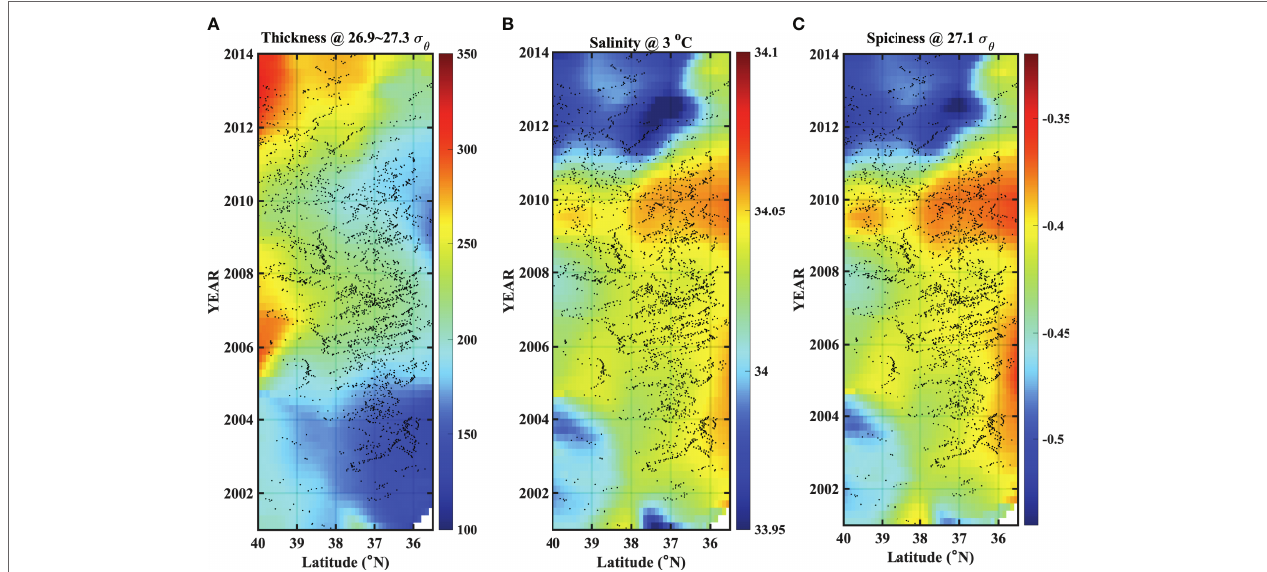
FIGURE 4 | (A) Hovmoller diagram for the ESIW thickness (meter) from Argo float data within the solid-line rectangular box (35°N−40°N, 131°E−132°E) in Figure 1B . (B) The same as panel (A) but for salinity (g/kg) at 3°C and (C) for spiciness at 27.1 σ